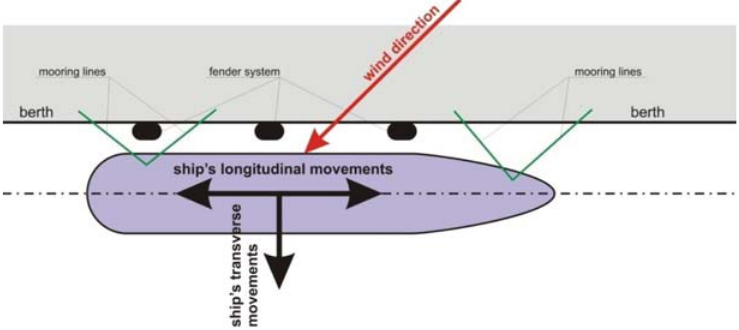
Fig. 10. Aerodynamic loads directed from the